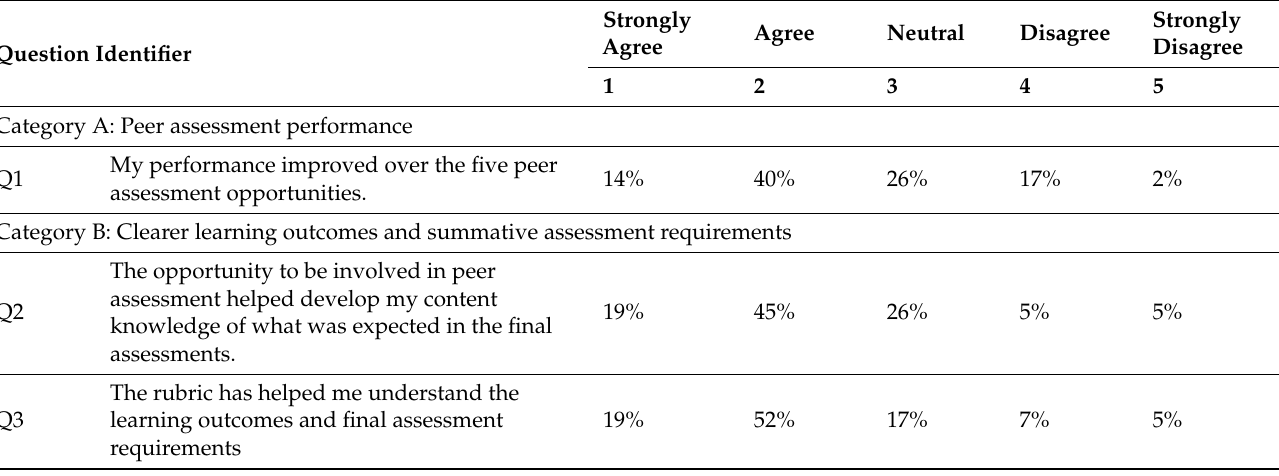
Table 2. Closed-ended